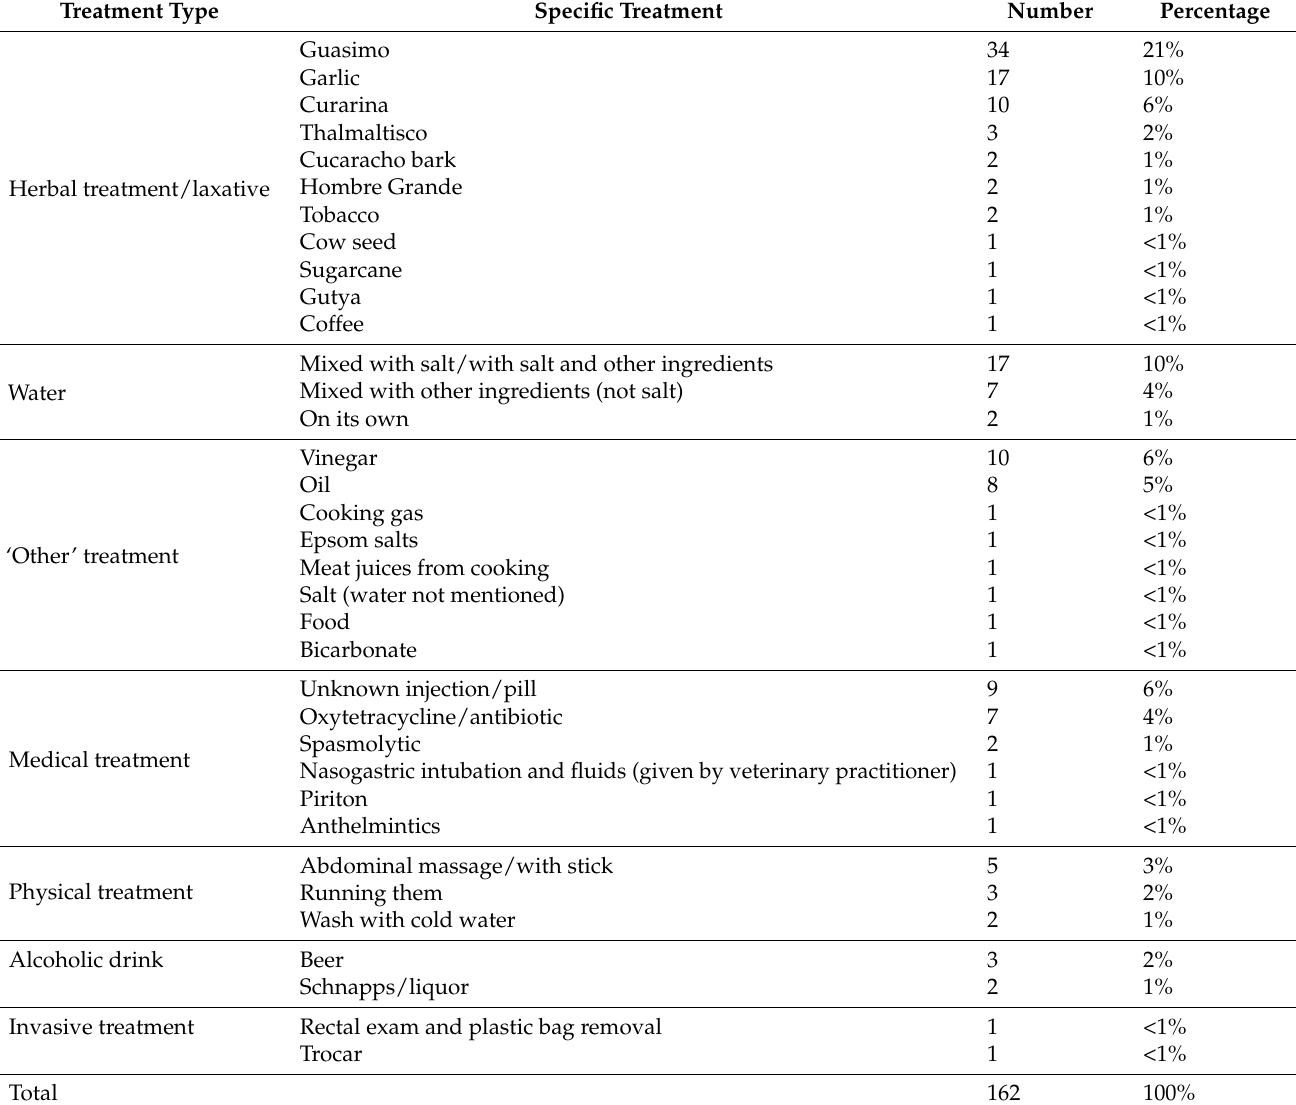
Table 3. Treatments of equids with colic listed by 67 owners in Choluteca, Honduras during verbal questionnaires. Number indicates the total number of owners that gave this response, which were totaled, and a percentage given to each symptom. A total of 162 treatments were mentioned, i.e., some owners mentioned more than one treatment they use for colic. Guacimo, hombre grande, cow seed, thalmaltisco, cucaracha trunk, gutya, and curarina all refer to local herbal remedies. Treatment